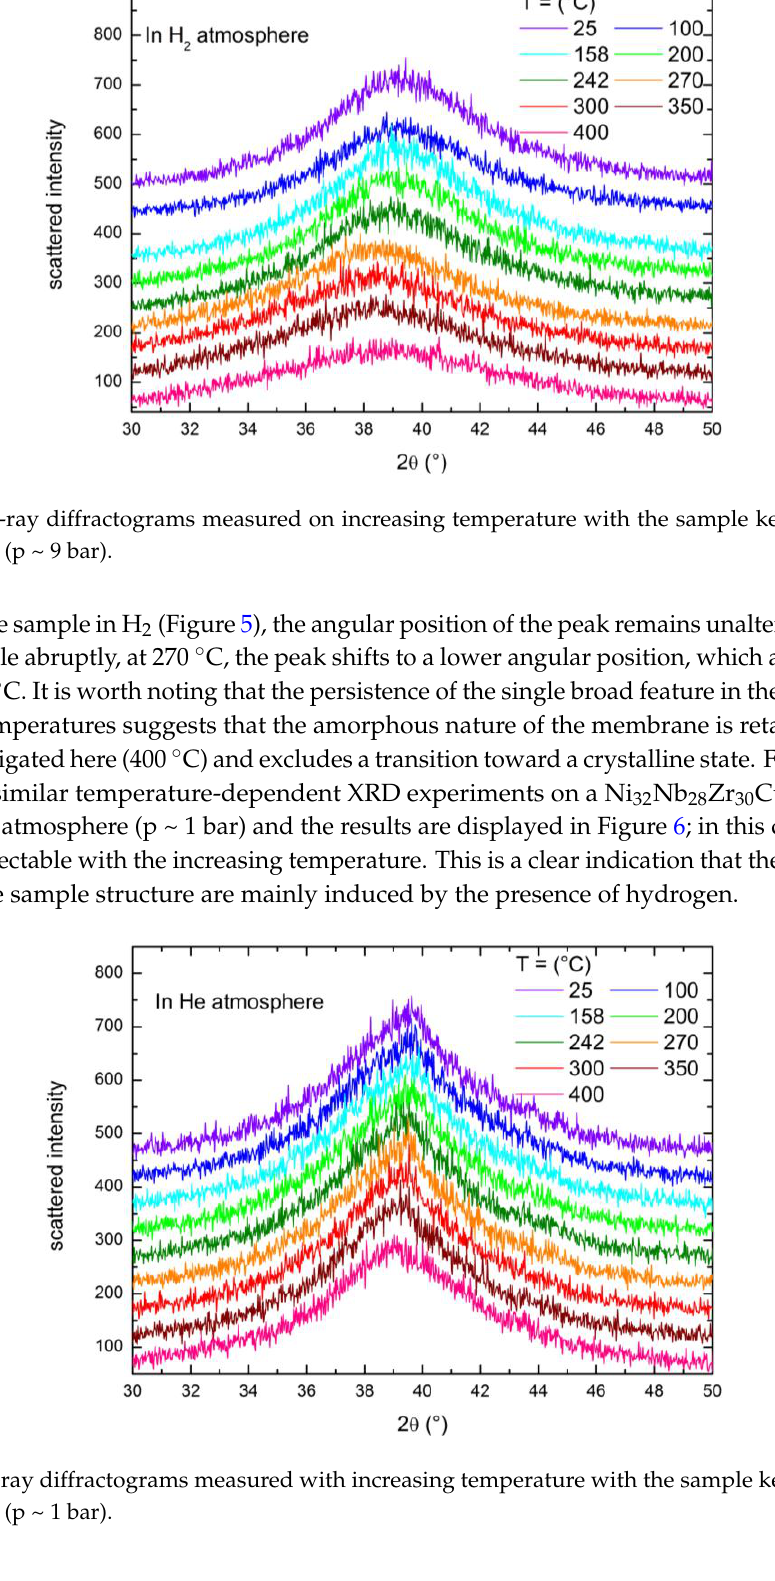
Figure 6. X-ray diffractograms measured with increasing temperature with the sample kept in a He atmosphere (p ~ 1 bar).